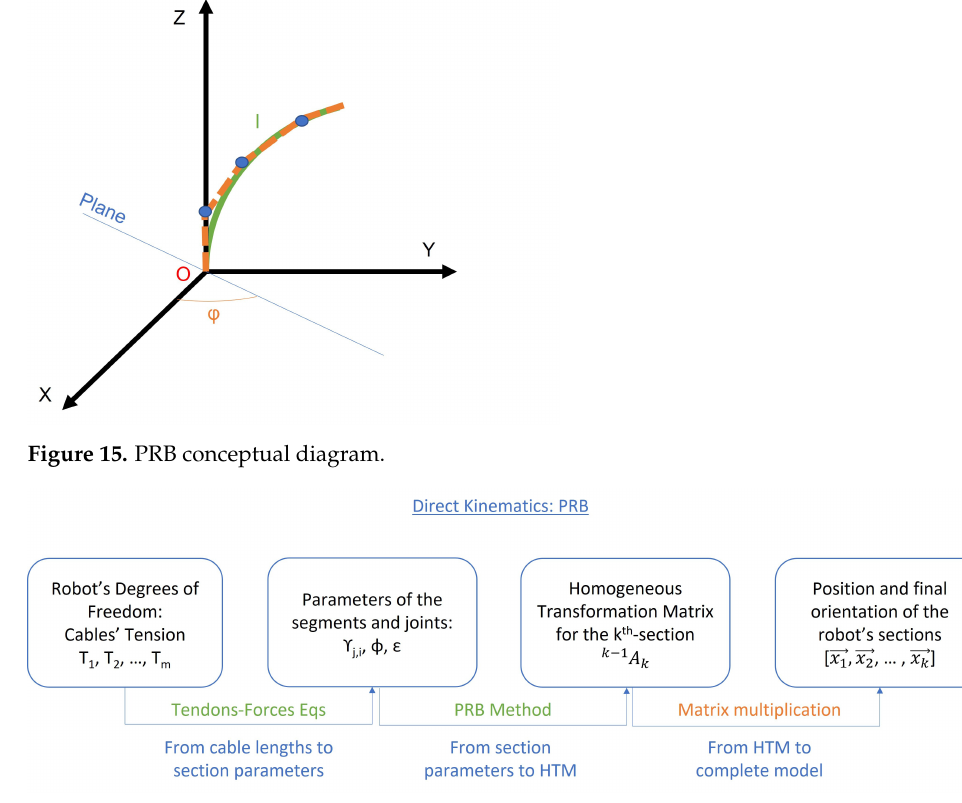
Figure 16. Inverse kinematics for